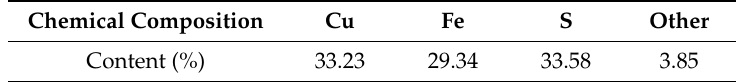
Table 1. Chemical composition of the chalcopyrite sample used in this research. Chemical